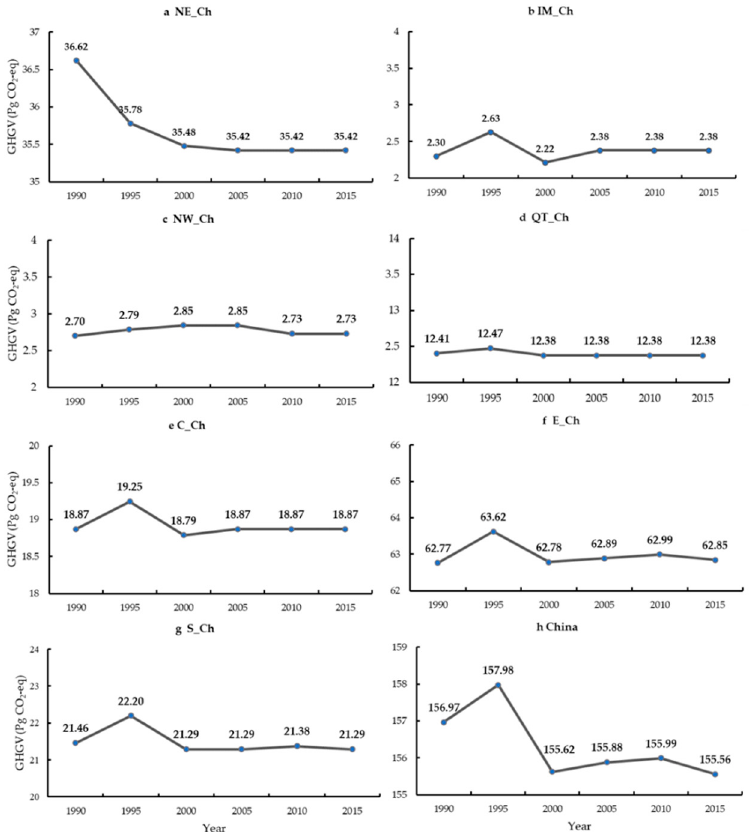
Figure 3. Changes of greenhouse gas value (GHGV) for forest ecosystems among various eco-geographical regions in China during 1990–2015. The acronyms in ( a – h ) are Northeast China (NE_Ch), Inner Mongolia (IM_Ch), Northwest China (NW_Ch), Qinghai-Tibet (QT_Ch), Central China (C_Ch), East China (E_Ch), South China (S_Ch), and China, respectively.